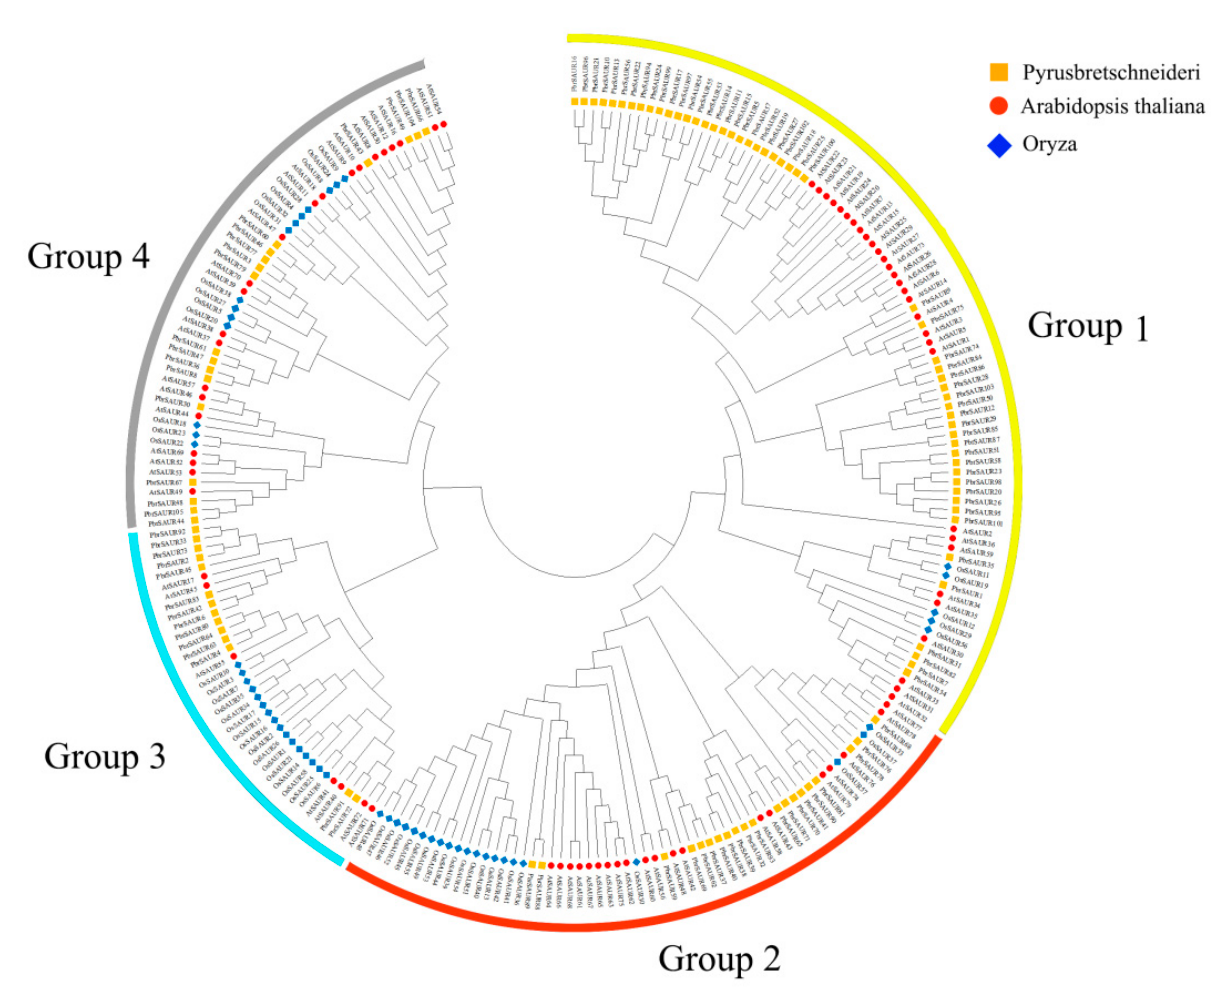
Figure 1. Phylogenetic relationships and subfamilies in SAUR proteins of ‘Dangshansu pear’ ( Pyrus bretschneideri ), Arabidopsis thaliana, and Oryza sativa . Group 1–4 are represented by yellow, red, blue, and gray, respectively.